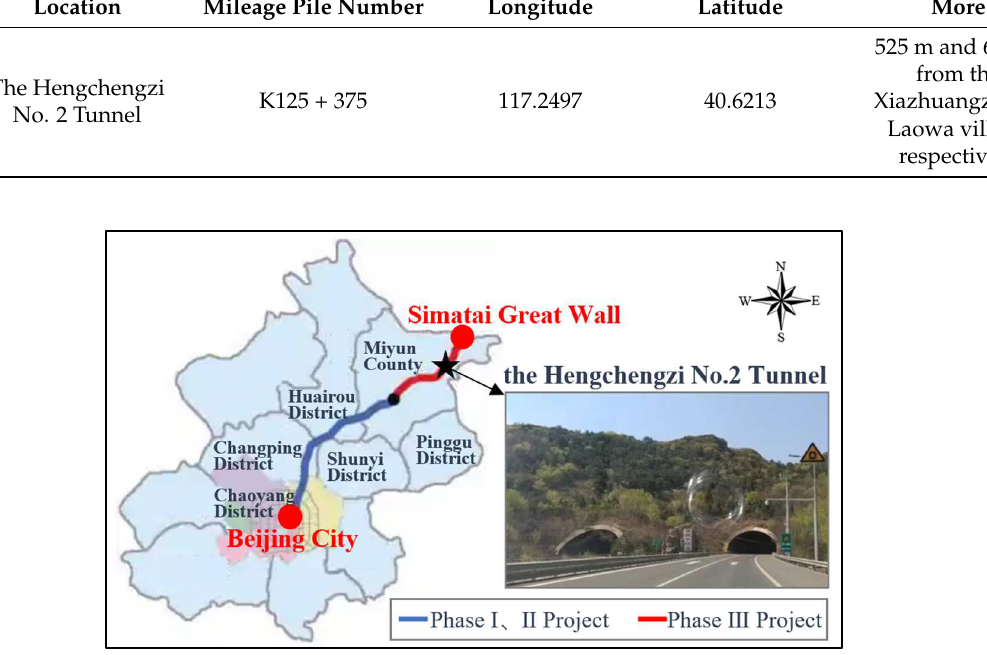
Table 1. Detailed conditions of the typical section of the study case.